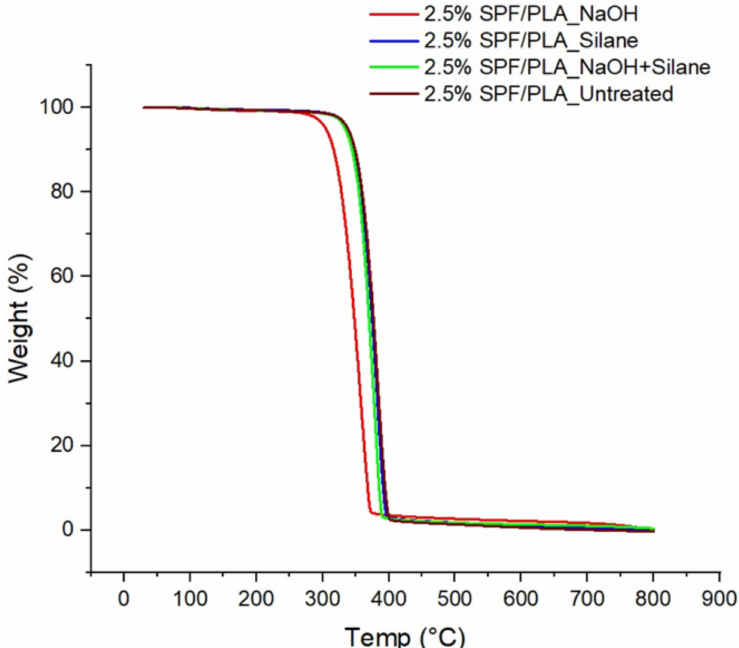
Figure 5. TGA results of 2.5% SPF/PLA filament composites. Table 3. Results obtained from the TGA